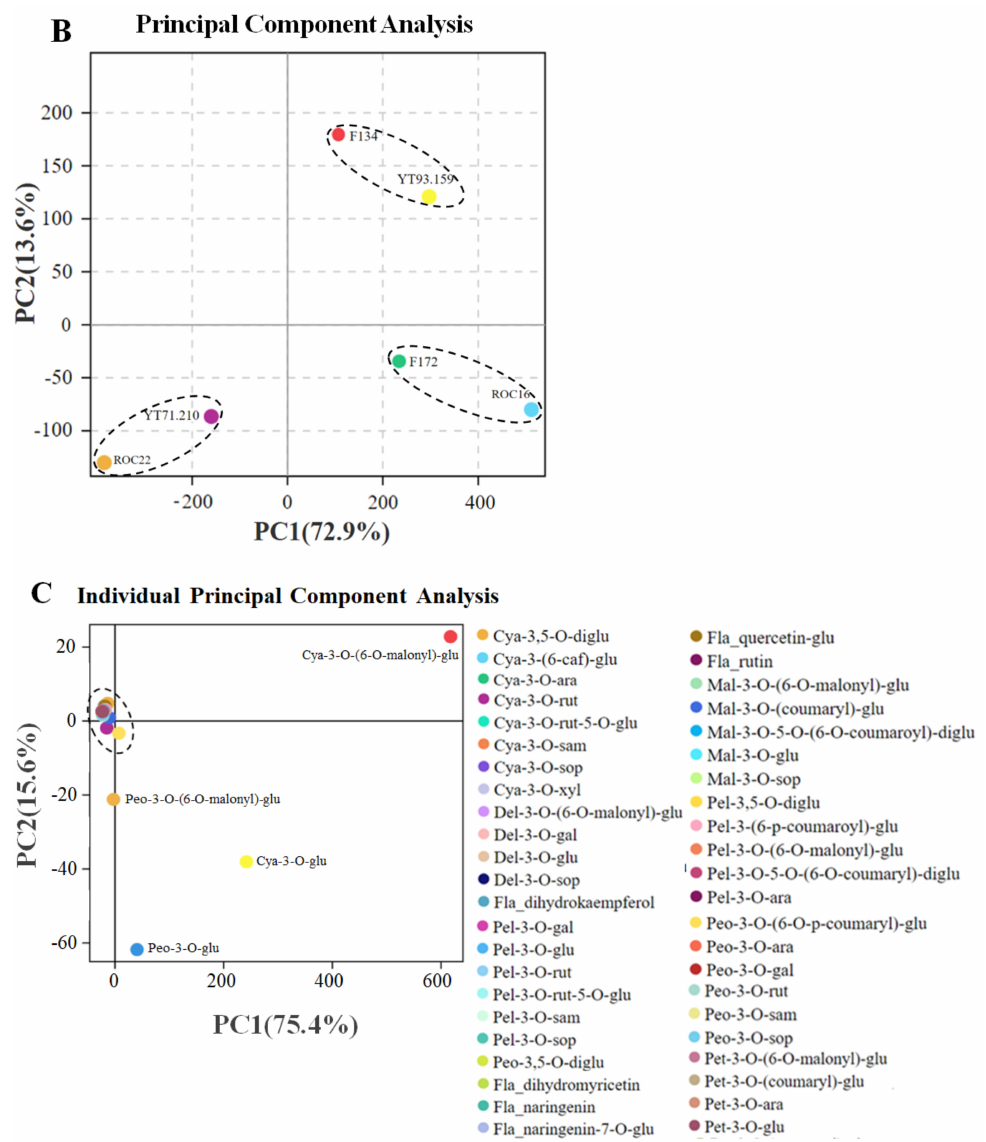
Figure 2. Hierarchical cluster analysis and principal component analysis (PCA) of anthocyanins in six sugarcane rinds. ( A ) Heat map of anthocyanin metabolites and sugarcane cultivars. The columns represent sugarcane cultivars and rows represent the flavonoid and anthocyanin metabolites; ( B ) Sugarcane cultivar wise PCA; ( C ) PCA by using individual anthocyanin metabolite